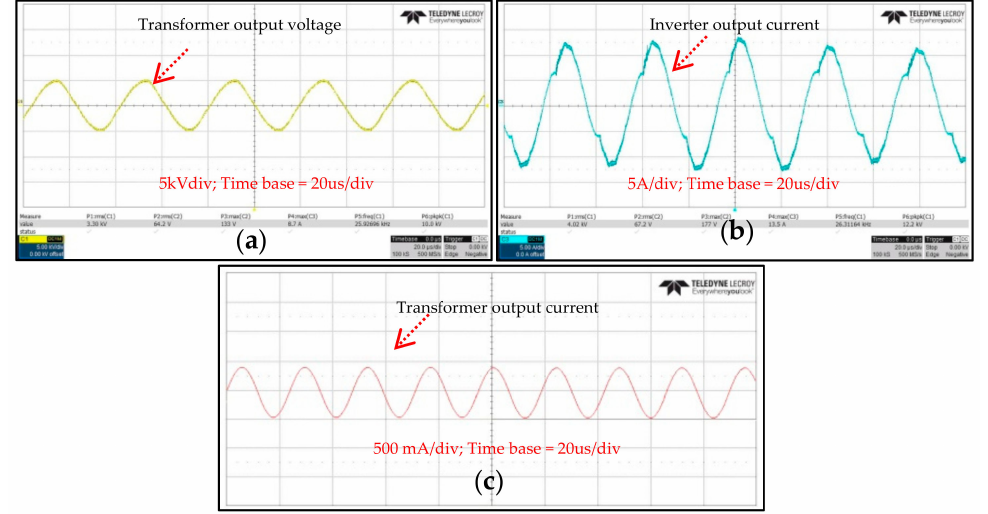
Figure 9. HVHF plasma switching power supply output waveforms. ( a ) Transformer output voltage; ( b ) Inverter output current; ( c ) Transformer output